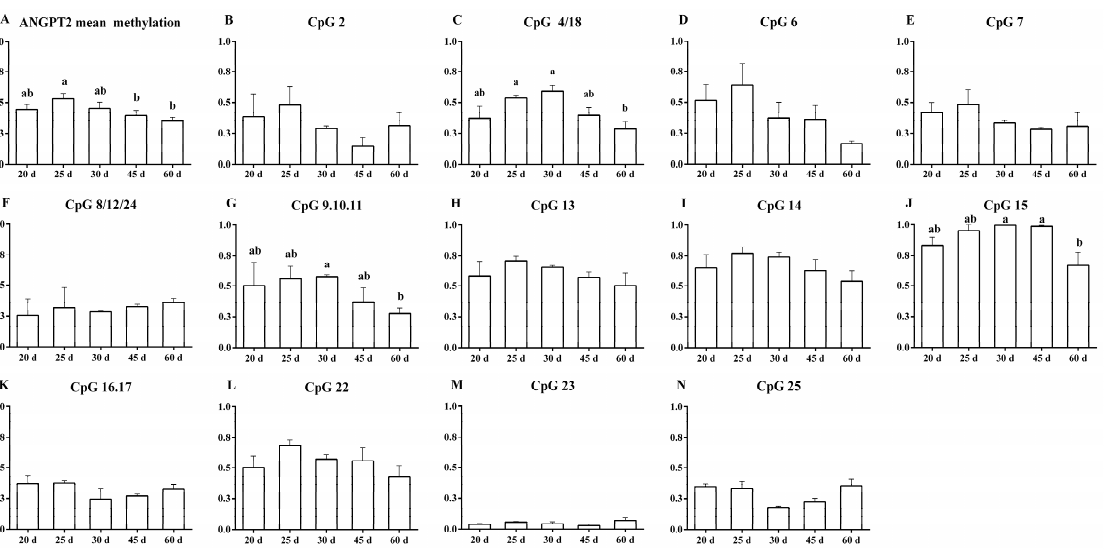
Values in bold indicate significant r 2 values.